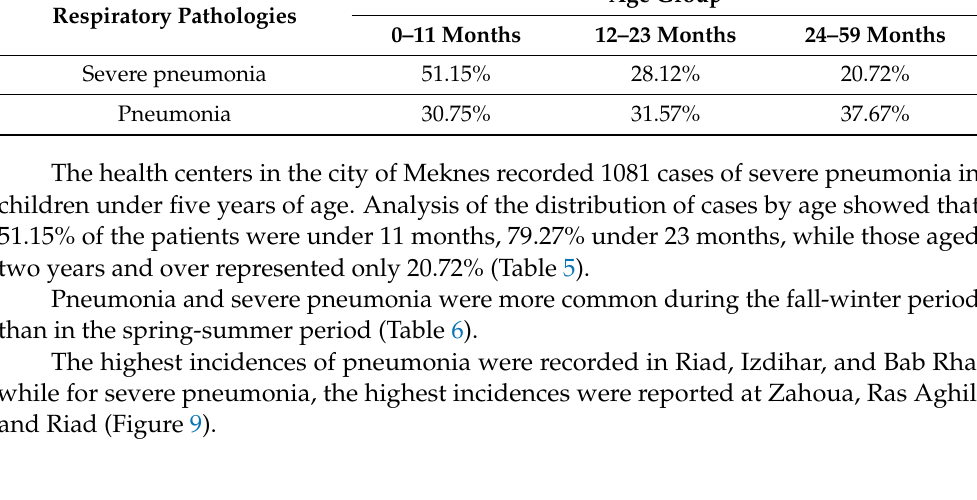
Table 5. Distribution of respiratory diseases in children under five by